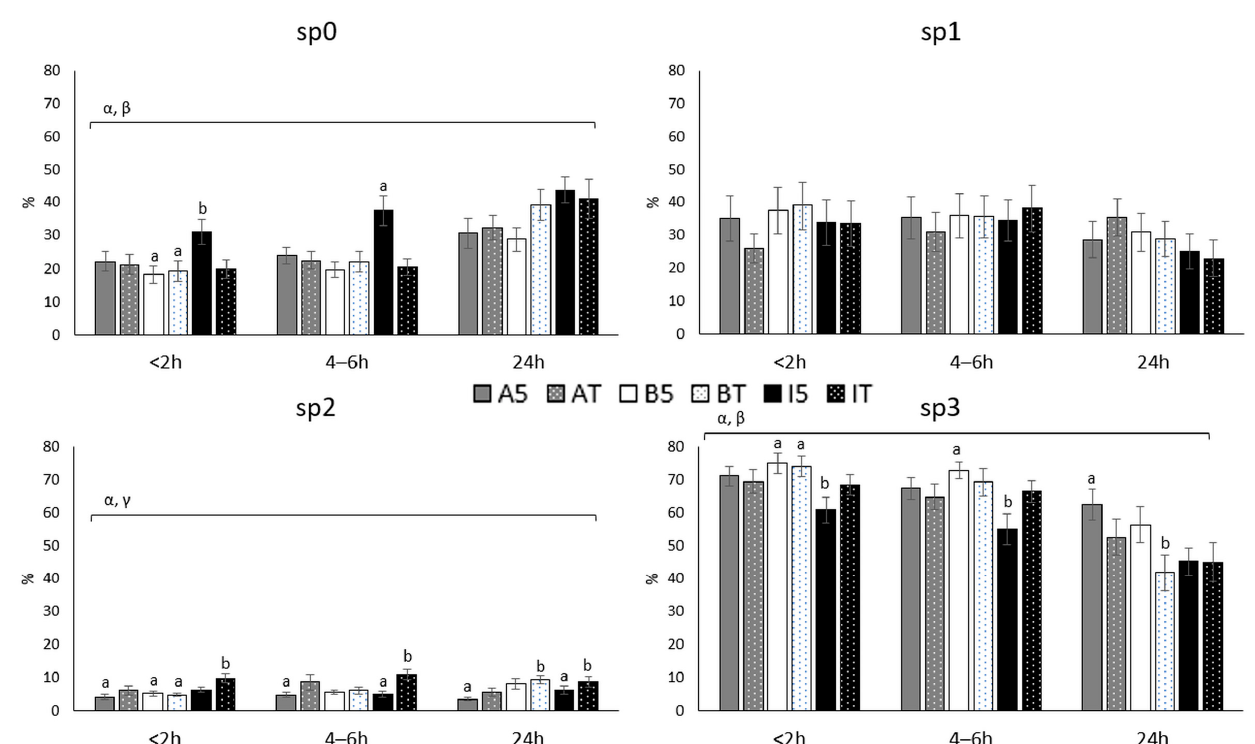
Figure 2. Percentage of bull motile sperm subpopulations (CASA), after storage for three periods (<2, 4–6 and 24 h), in the presence of three extenders (AndroMed ® , BIOXcell ® and INRA96 ® ) and two holding temperatures (refrigeration vs. room temperature). Bars with different letters mean statistical significantly different values ( p < 0.05) among the six combinations extender by holding temperature, at each time window (ANOVA analyses). Square brackets over the bars highlight statistically significant effects ( p < 0.05; from GLM analyses) of the factors or factors’ interactions (Greek letters), during the time-windows embraced. Abbreviations: CASA: Computer Assisted Semen Analyses; sp0: static subpopulation; sp1: slow subpopulation; sp2: medium speed subpopulation; sp3: fast subpopulation. A: AndroMed ® ; B: BIOXcell ® ; I: INRA96 ® ; T: room temperature; 5: refrigeration at 5 ◦ C. < 2h: time of assessment <2 h after collection; 4–6 h: time of assessment 4–6 h after collection; 24 h: time of assessment 24 h after collection; α : interaction temperature by extender; β : interaction temperature by time; γ : interaction extender by time; δ : interaction temperature by extender by